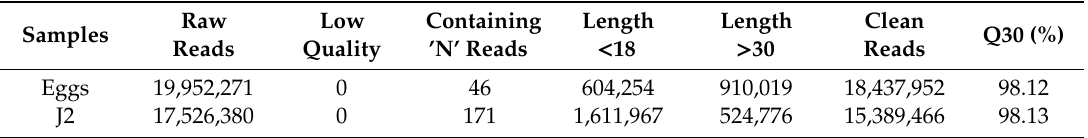
Table 1. Summary of the raw and clean reads generated from deep sequencing from two developmental stages of the root-knot nematode (RKN).